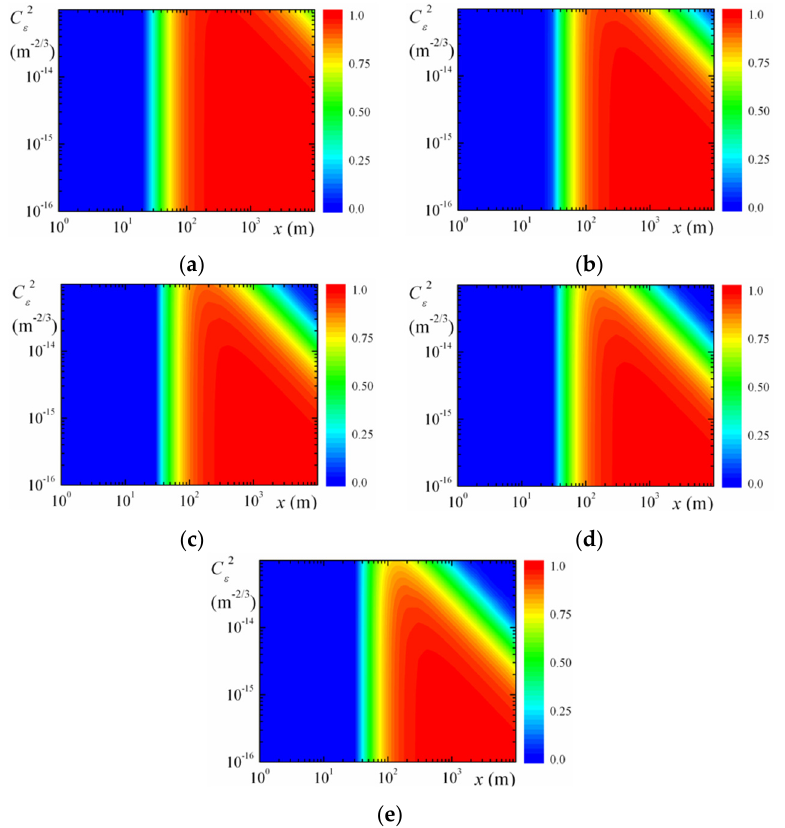
Figure 6. The contrast of ILS interference pattern for different distances between the centers of emitting beam apertures